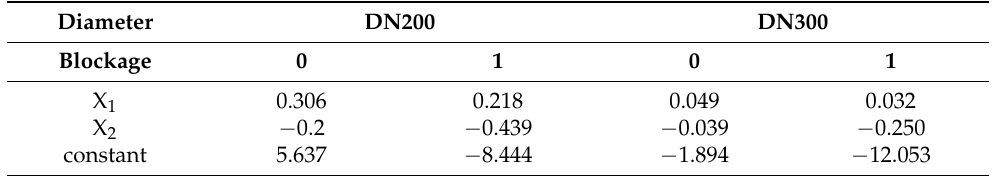
Table 3. Sewer blockage discriminant model coefficient.